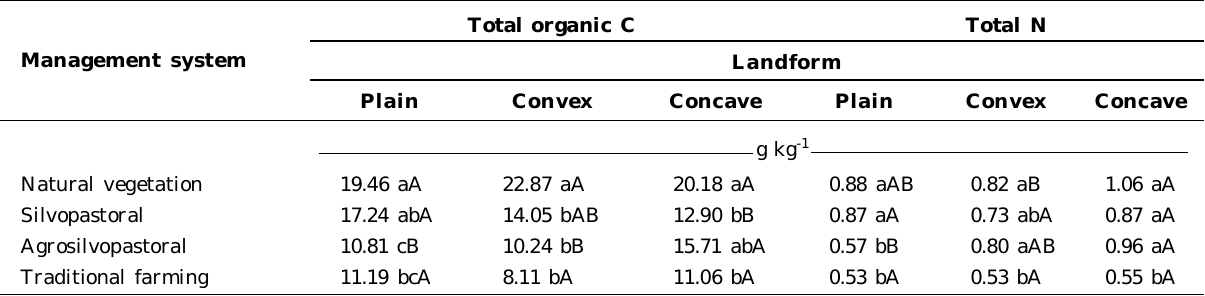
Table 3. Total organic C and total N contents in a typical Ortic Chromic Luvisol under natural vegetation and silvopastoral, agrosilvopastoral and traditional agricultural systems in the plain, convex and concave landforms after 13 years of cultivation in Sobral, Ceará, Brazil